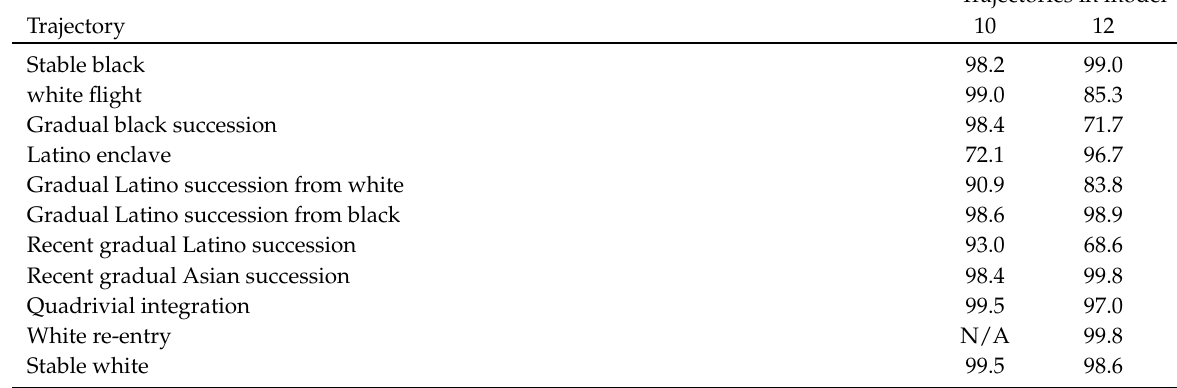
Table 3: Percentage of neighborhoods classified in 11-trajectory model with same classification in 10-trajectory and 12-trajectory